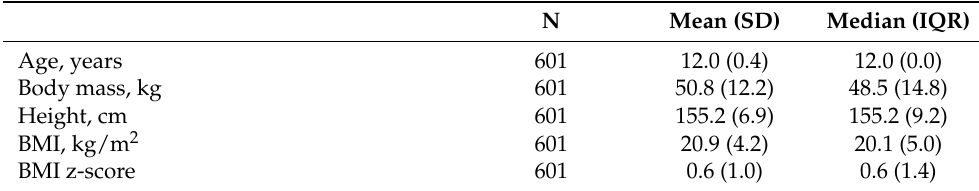
Table 2. General characteristics of the